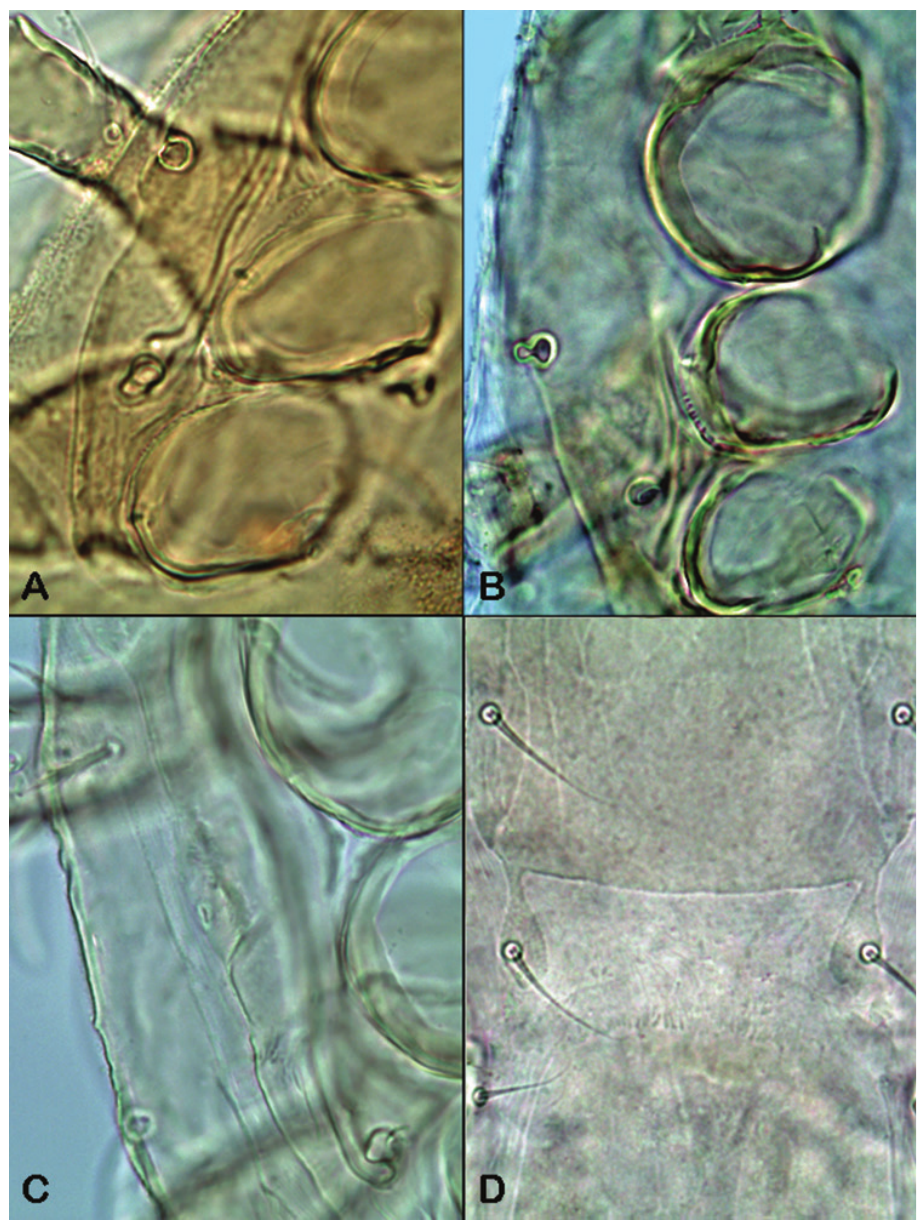
Plate 77. Ameroseiidae spp., female. A–C Poroid structure associated with peritrematal shield. A